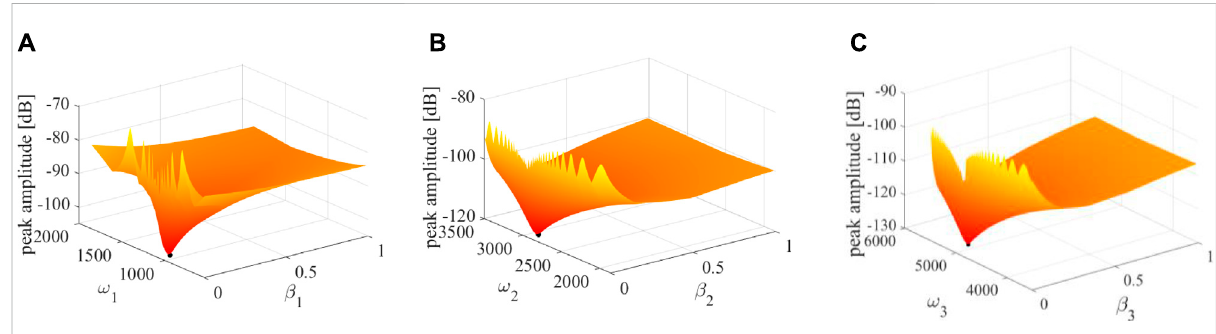
FIGURE 6 In fl uencesof ω p , i and β i onthe peakamplitudes oftheresponses atpoint O inFigure 4near the (A) fi rst and second, (B) third andfourth, (C) fi fth resonant modes,